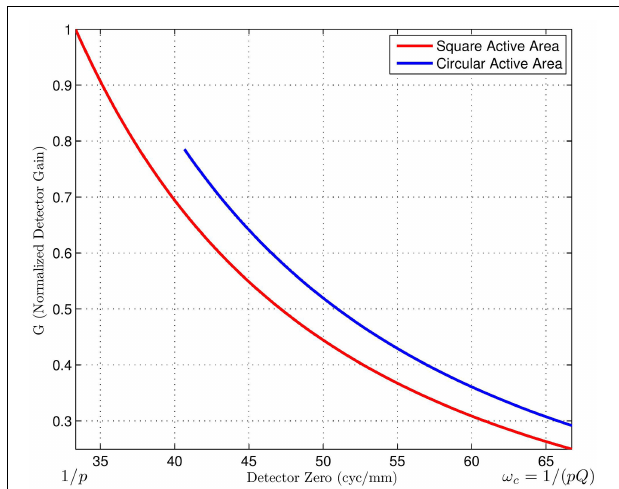
FIGURE 14 | Detector integration gain vs. the detector zero frequency. The gain plotted relative to a 100% fill factor detector with a = 30 μ m having a zero at ω = 1 / p . Note that to move the detector zero out toward the optical cutoff frequency, a and b must be decreased for rectangular and circular detectors, respectively. The resulting reduction in fill factor causes a lowering of the gain. Interestingly, the circular detector can achieve the higher detector zero with a somewhat larger area.